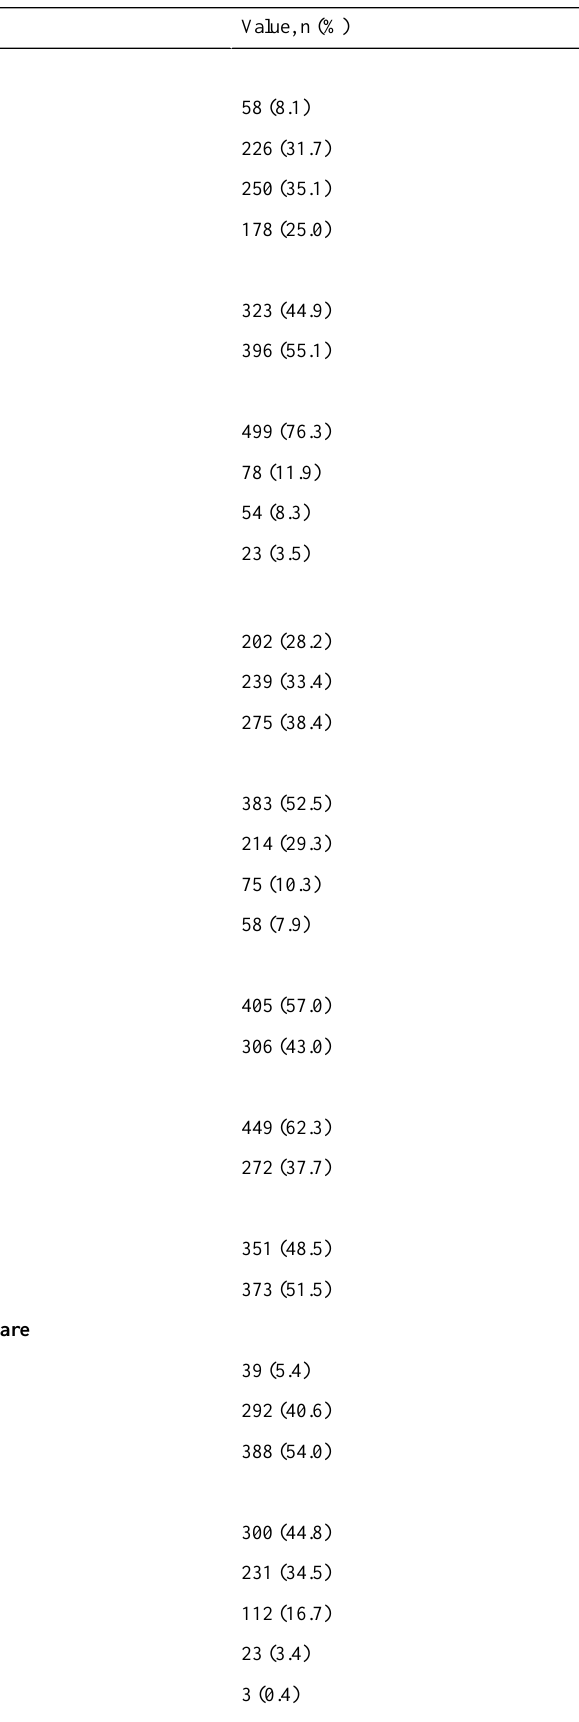
Table 2. Demographic characteristics of the sample